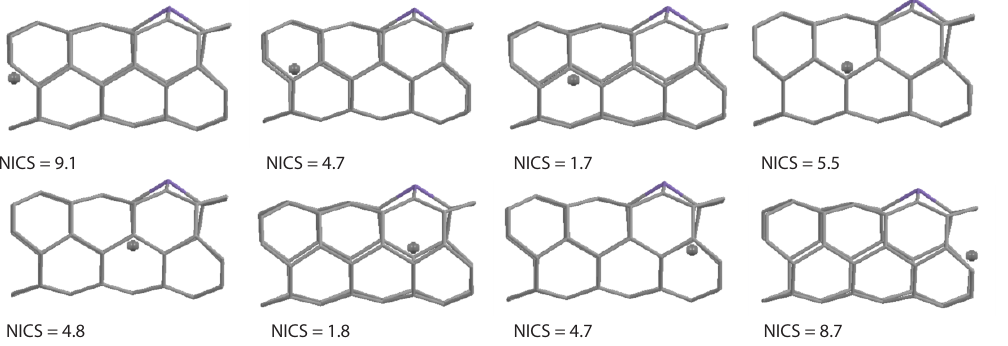
Figure 4. Axial NICS scanning of (3,3)-Si(L) (C